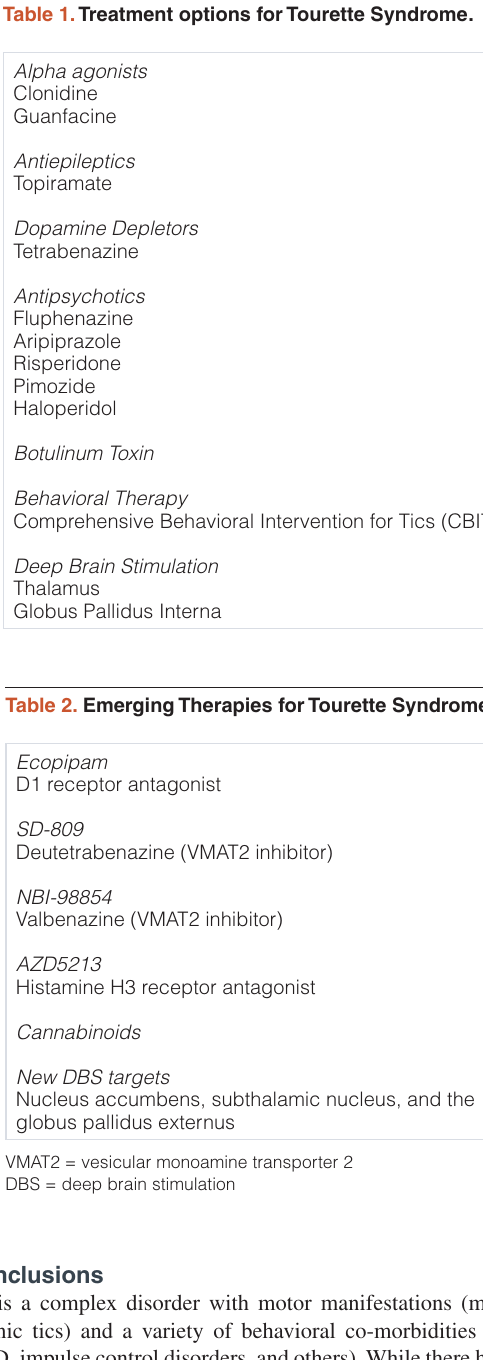
Table 1. Treatment options for Tourette Syndrome.